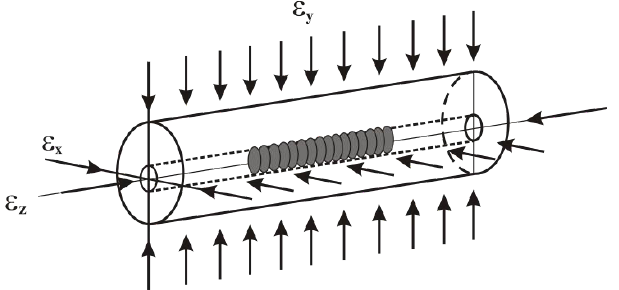
Figure 1. Schematic of an optical fiber with an FBG sensor subjected to